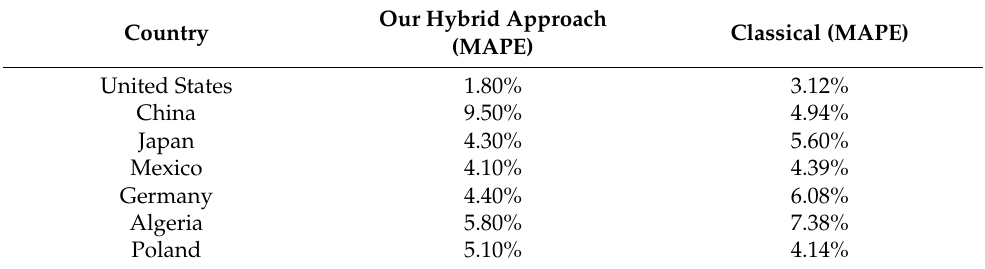
Table 7. Forecast errors for selected countries in classic and hybrid